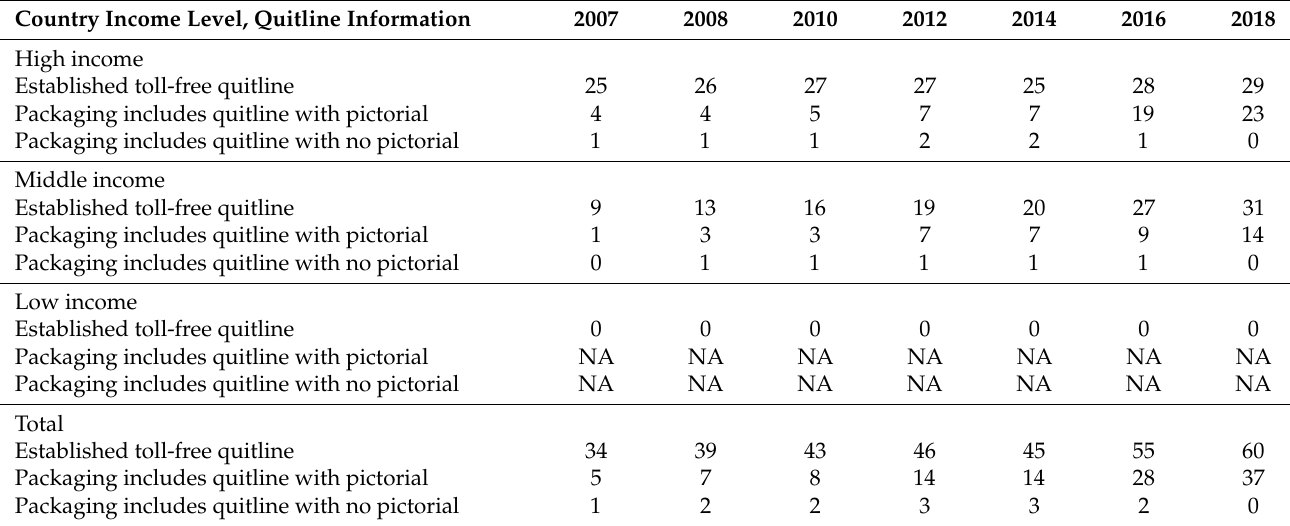
Table 1. Countries that have quitlines and cigarette packaging that includes quitline information with or without a graphic pictorial by income level, 2007–2018.